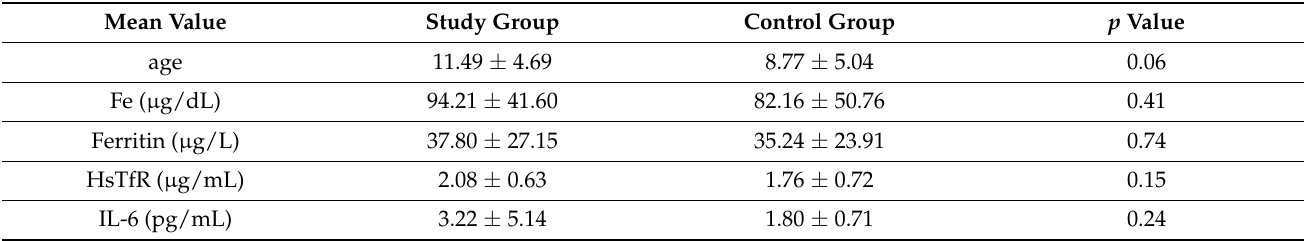
Table 1. Comparison of age and iron homeostasis parameters between study ( n = 17) and control group ( n = 47). Mean